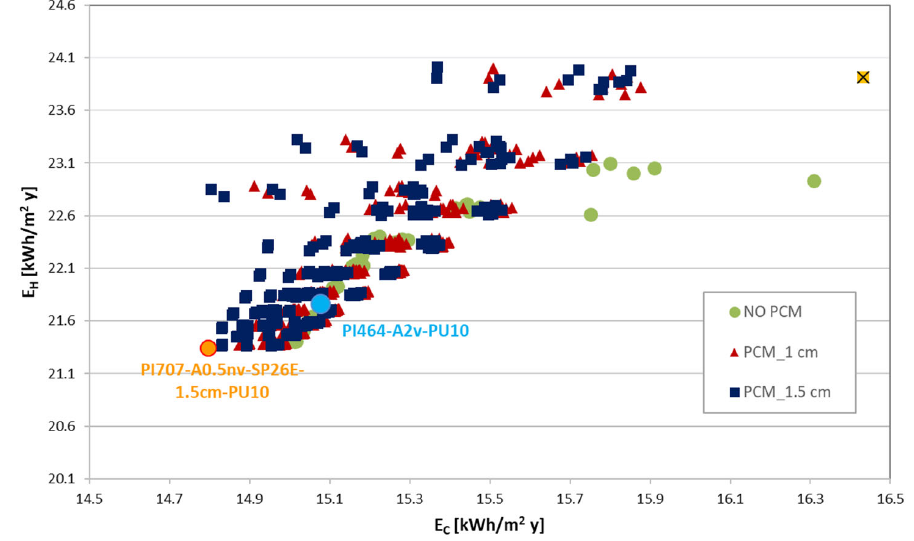
Figure 8. PCMs on external side: comparison based on heating and cooling load.